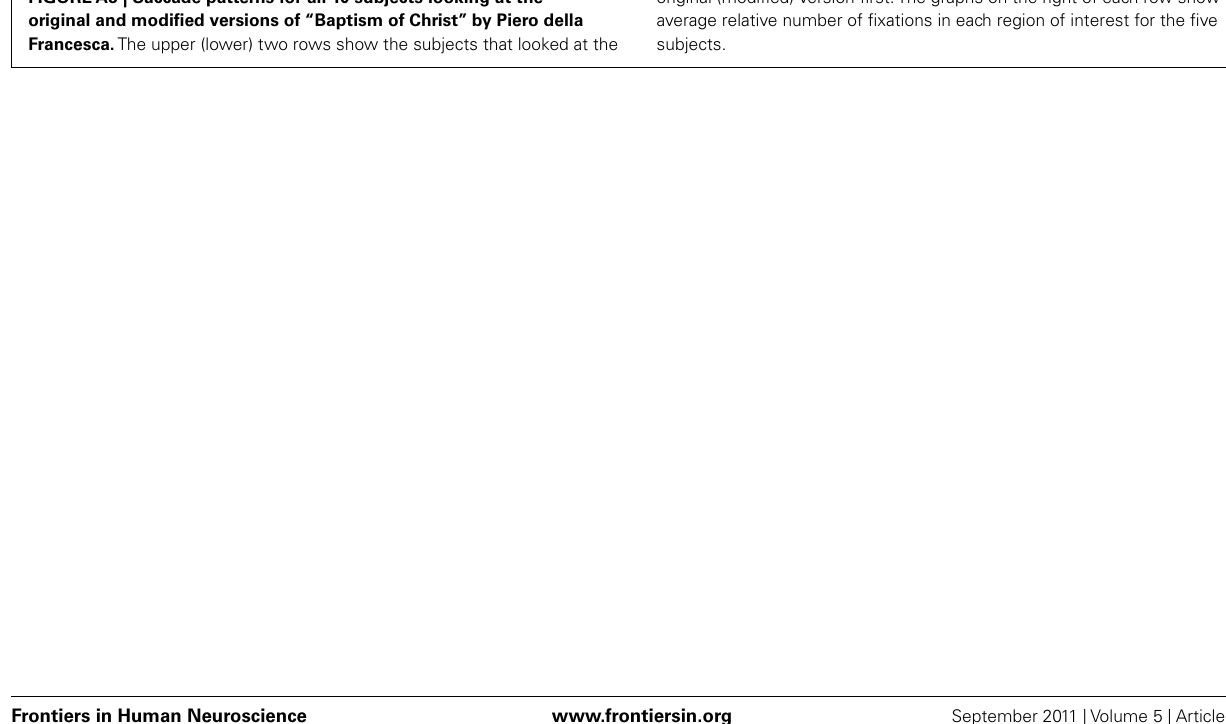
FIGUREA5 | Saccade patterns for all 10 subjects looking at the original and modified versions of “Baptism of Christ” by Piero della Francesca. The upper (lower) two rows show the subjects that looked at the